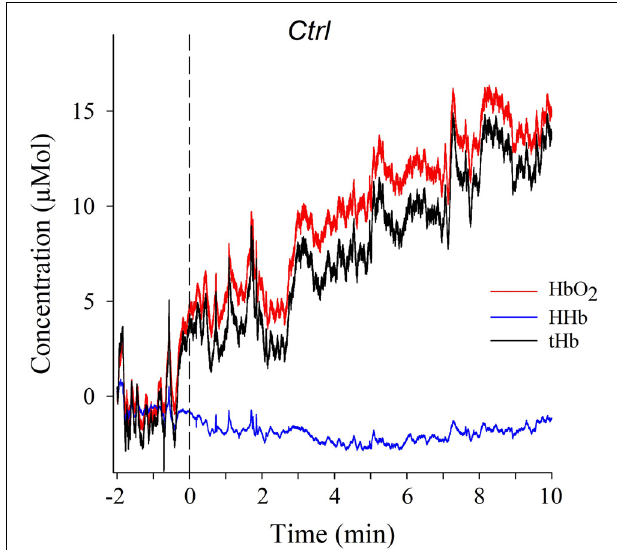
FIGURE 3 | Typical NIRS time series plot of individual changes in HbO 2 , HHb, and tHb during the 2-min baseline condition (to the left of the stippled vertical line), and during the 10-min visual Ctrl condition (to the right of the stippled vertical